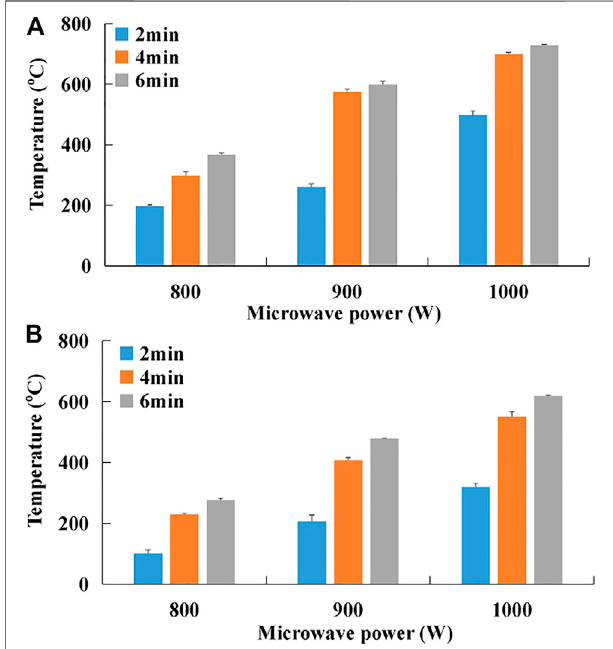
FIGURE 6 | Effects of microwave energy activation on temperature- rising property of wheat straw hydrochar [ (A) HTC-PWR2 hydrochar; (B) HTC-PWR3